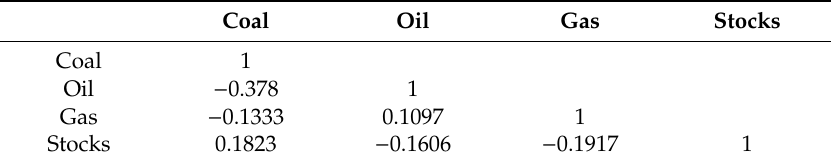
Table 20. Correlations for UK.